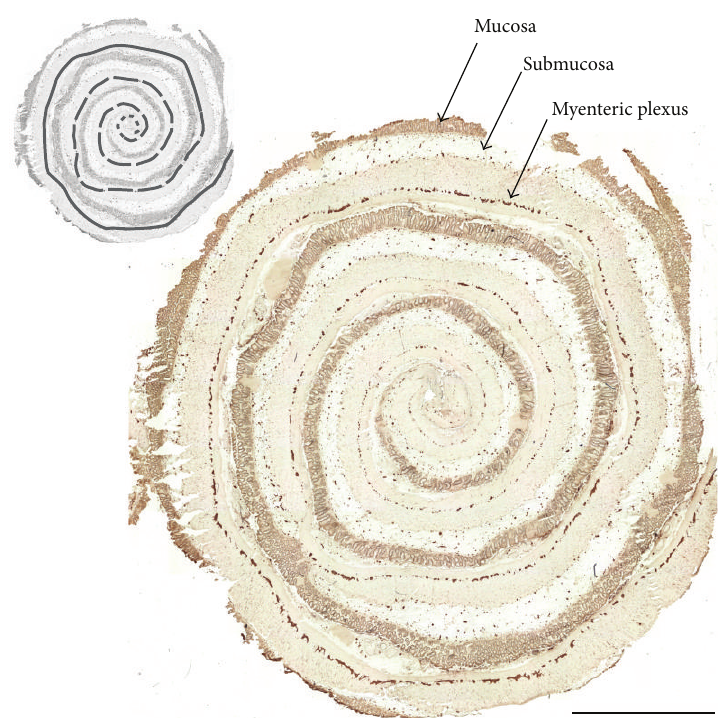
Figure 6: Overview of immunostained section sliced from “Swiss-rolled” tissue of Hirschsprung’s disease. Cryostat section from large intestine diagnosed with Hirschsprung’s disease (sample number 10) was immunostained for peripherin; scale bar: 5 mm. The center of the “Swiss-rolled” tissue marks the distal end of resected intestinal segment. In the microscopic view at the upper left corner normoganglionic, hypoglanglionic, and aganglionic areas are marked by an unbroken, broken, and dotted line, respectively. NTR (mean ± SD) of p 75 positive cells expressed the Wnt receptor, whereas almost all cells found positive for frizzled-4 also expressed p 75 NTR (93.3% ± 8.9% (mean ± SD)).